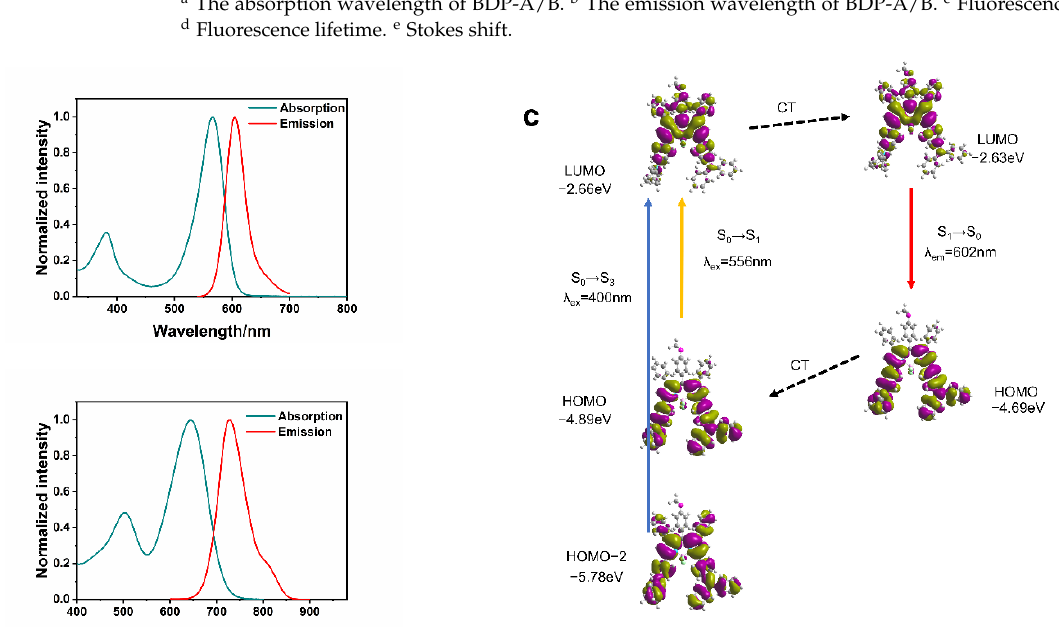
a The absorption wavelength of BDP-A/B. b The emission wavelength of BDP-A/B. c Fluorescence efficiency. d